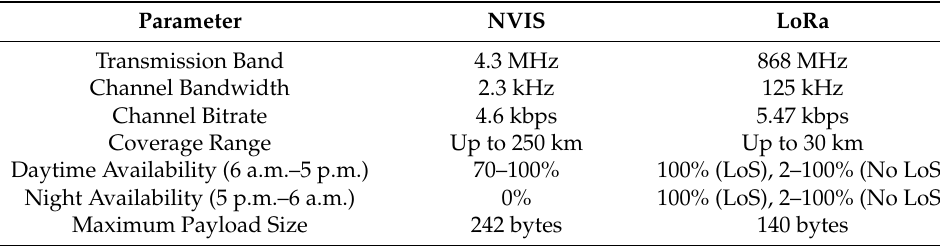
Table 3. Network parameters used to model the scenario.